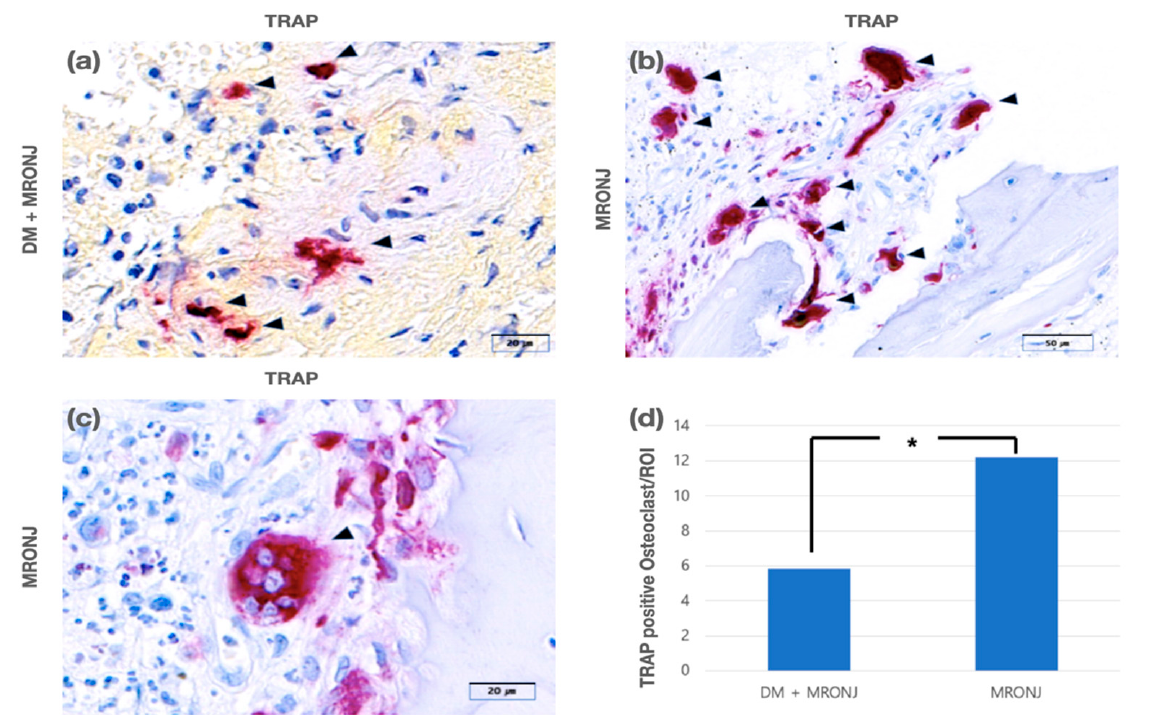
Figure 4. ( a ) TRAP-positive osteoclasts (arrowhead) in the DM + MRONJ group (TRAP staining). ( b ) TRAP-positive osteoclasts (arrowhead) in the MRONJ group (TRAP staining). ( c ) TRAP-positive giant osteoclasts in the MRONJ group (TRAP staining). ( d ) There were significantly fewer TRAP- positive osteoclasts in the DM + MRONJ group than in the MRONJ group (* p < 0.05). 3.2. Immunohistomorphometric Analysis (DC-STAMP Expression) DC-STAMP-positive cells showed brown cell membranes and cytoplasm and were observed in both experimental and control groups. The number of DC-STAMP-positive cells was 78.1 ± 22.7 in the experimental group and 147.3 ± 57.4 in the control group. It was observed to be significantly less in the experimental group than in the control group ( p < 0.05) (Figure 5). The number of DC-STAMP-positive osteoclasts was 2.3 ± 1.7 in the experimental group and 3.2 ± 1.9 in the control group. Although the number of DC- STAMP-positive osteoclasts was less in the experimental group, there was no significant difference between the two groups ( p >